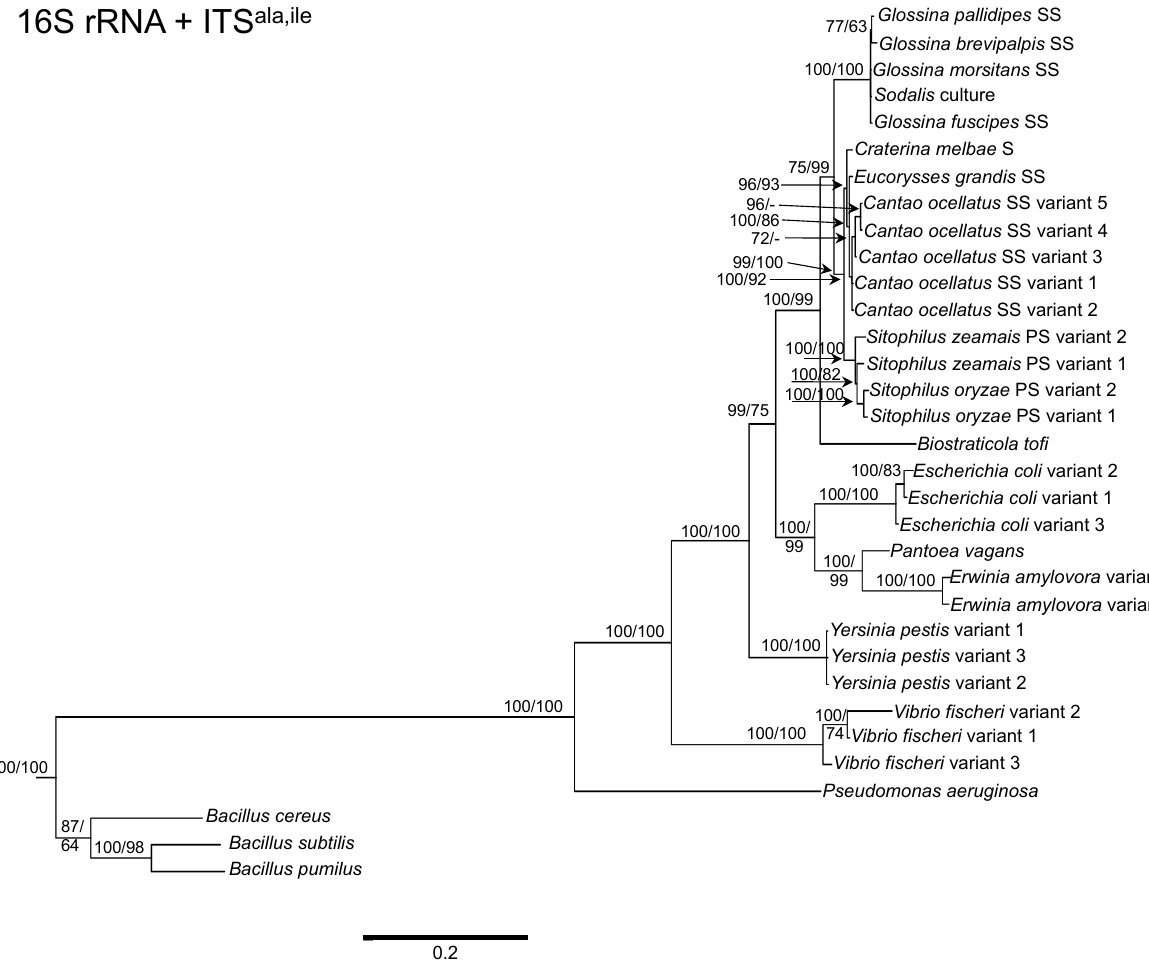
Figure 2. Phylogenetic placement of Sodalis and related symbiotic bacteria within Bacteria based on ITS ala,ile . A Bayesian tree, inferred from a total of 2,762 unambiguously aligned nucleotide sites, with support values indicating Bayesian posterior probabilities (PP)/ MP bootstrap (BS) is shown. PP indicated as percentage, i.e ., PP = 0.95 is depicted as 95. Branches collapsed with Bayesian analysis are shown in bold. NJ analysis resulted in a similar phylogeny. For insect symbionts, host species are indicated. S = symbiont,